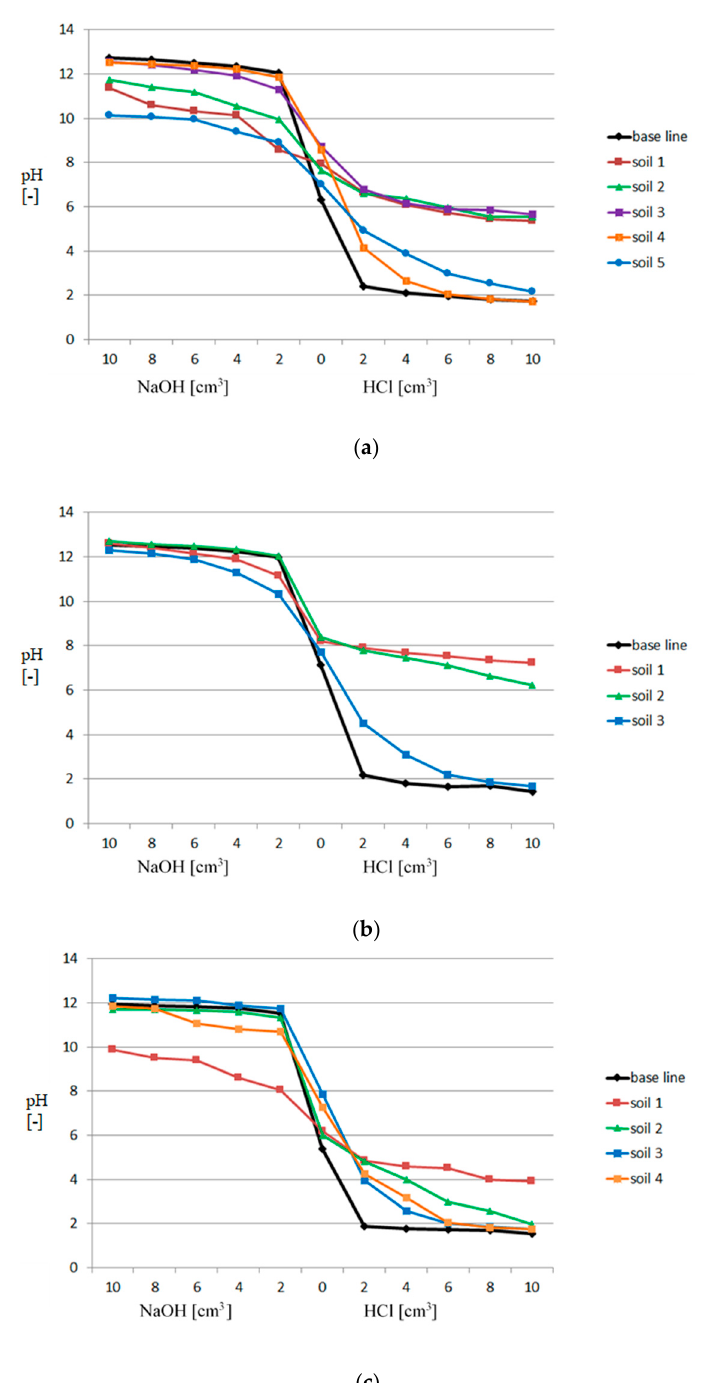
Figure 3. Buffer capacity of soil in the Paryz profiles ( a ) Paryz I, soil: 1 (4–9 cm)—organic stratum,